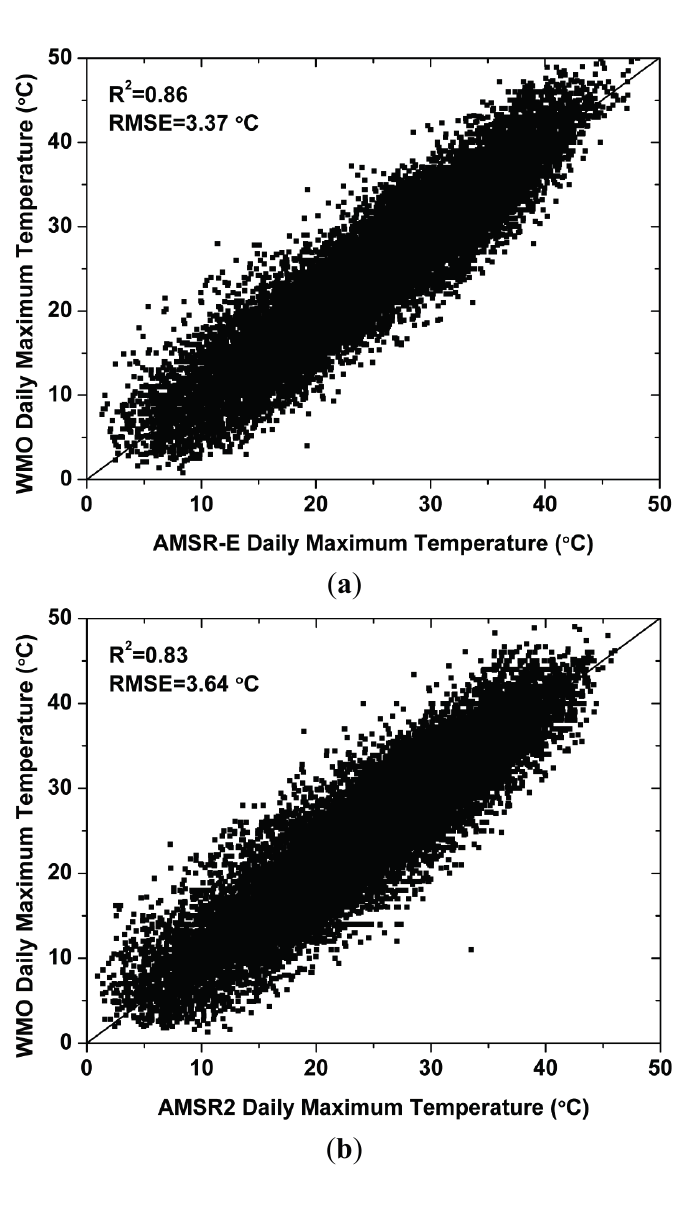
Figure 7. Example correspondence between in-situ daily T validation sites and corresponding temperature estimates from the ( a ) AMSR-E baseline and ( b ) calibrated AMSR2